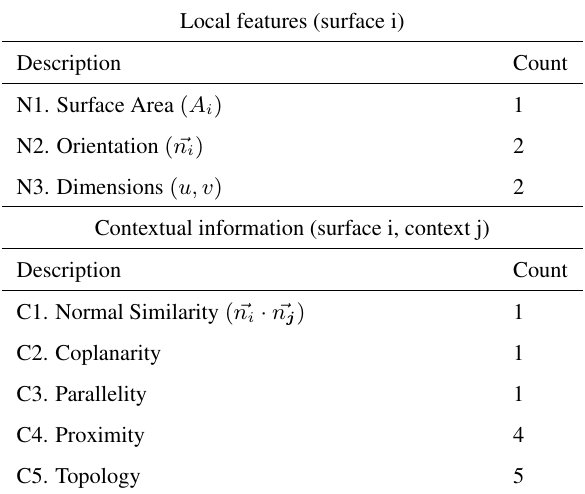
Table 1: Types of predictor